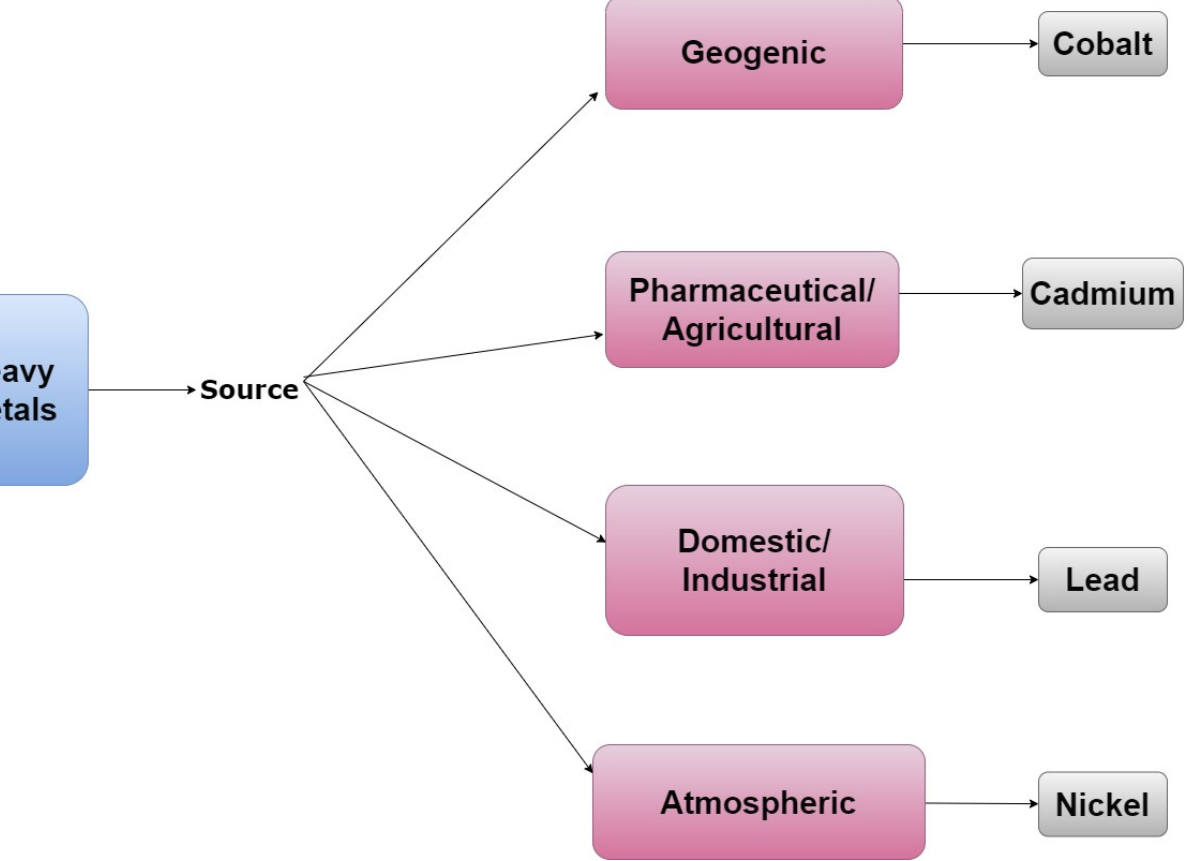
Figure 3. A tree diagram that lists representative examples of heavy metals and their emission